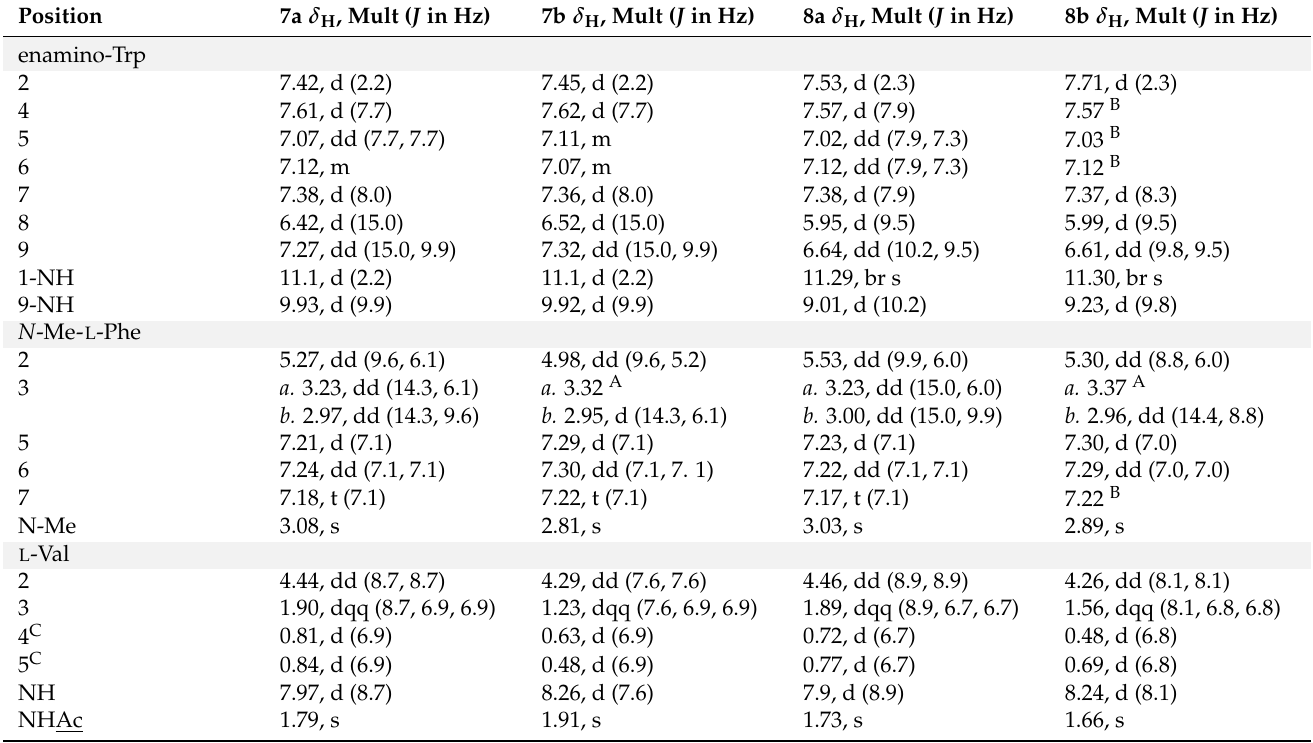
Table 1. 1 H NMR (DMSO- d 6 ) Data for Aspergillamides E–F ( 7 – 8 ).